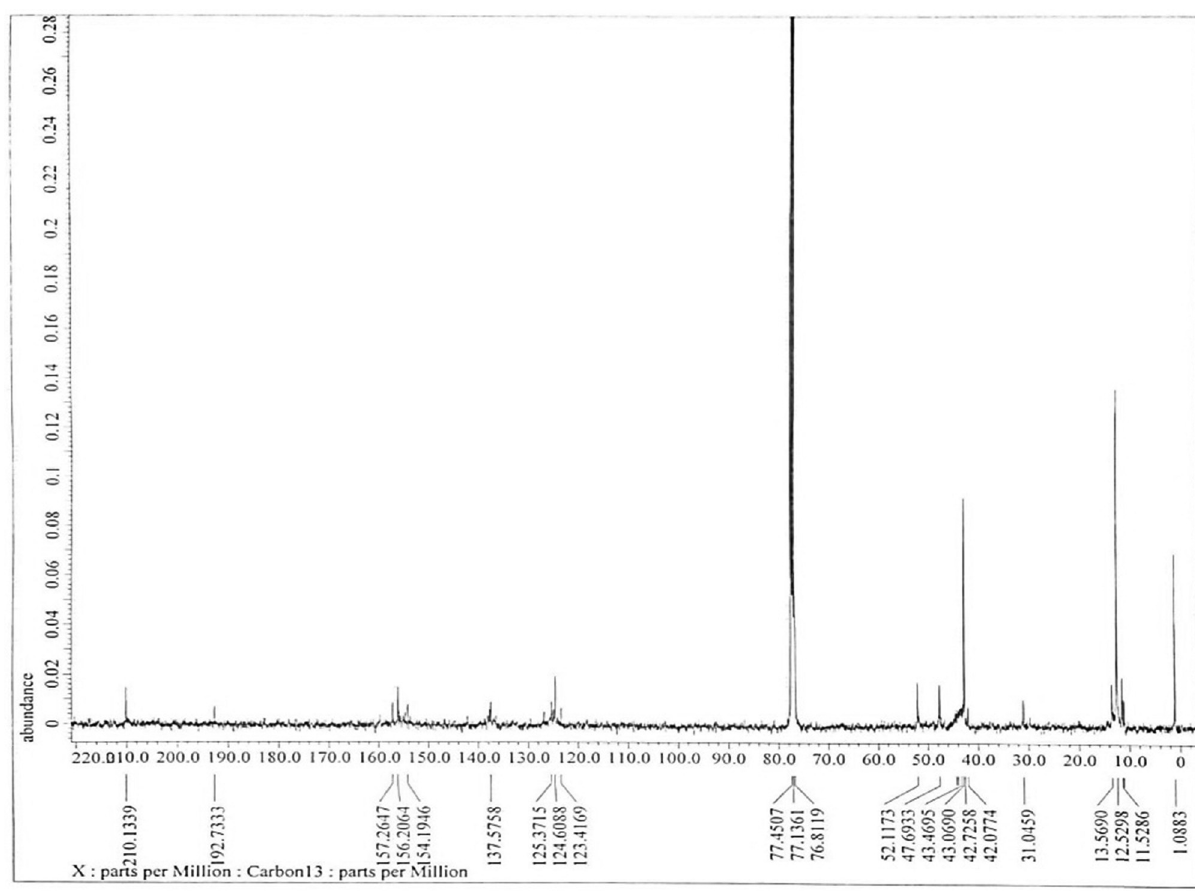
Figure A3: 13 C NMR spectrum of complex 1 .